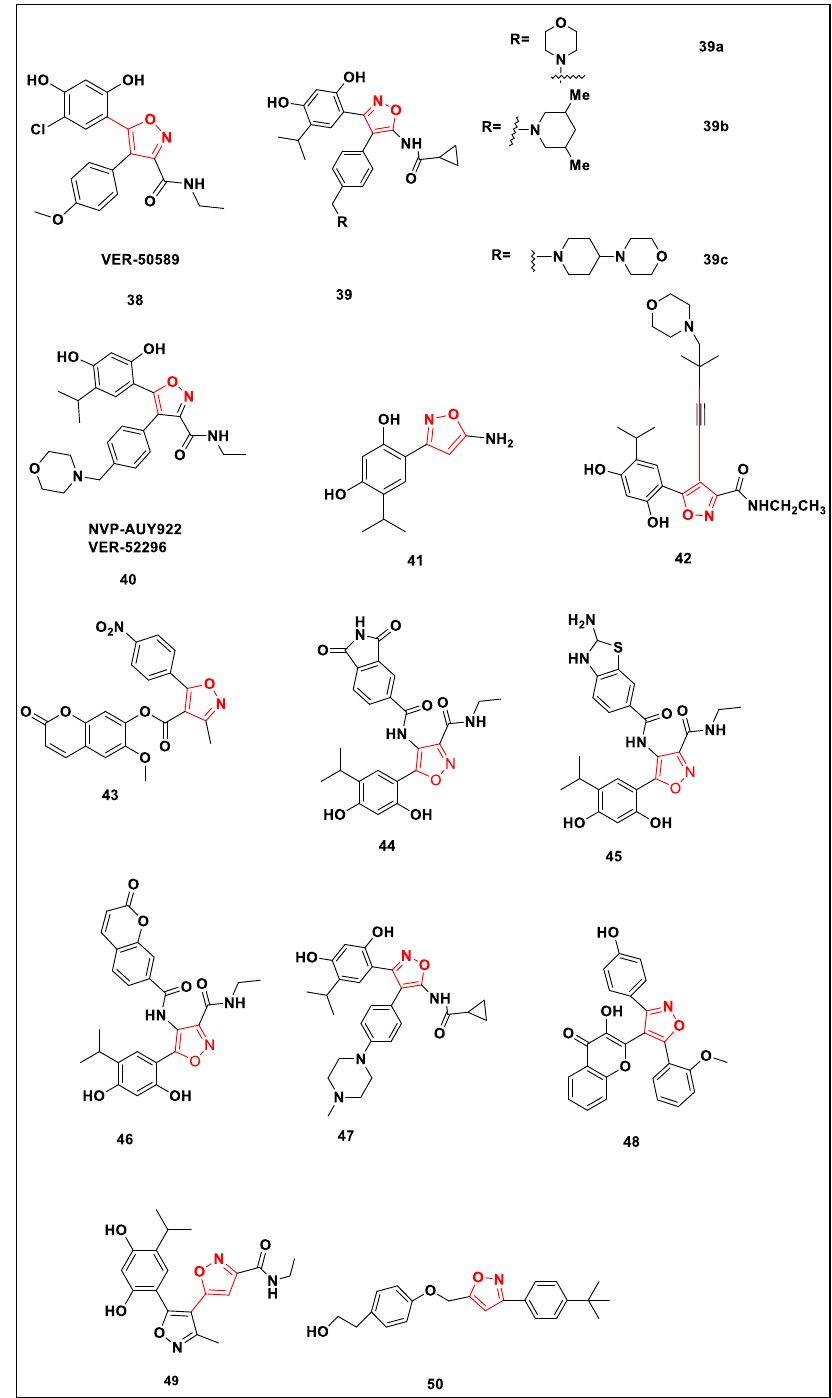
Scheme 12. Hsp90 inhibitors containing isoxazole